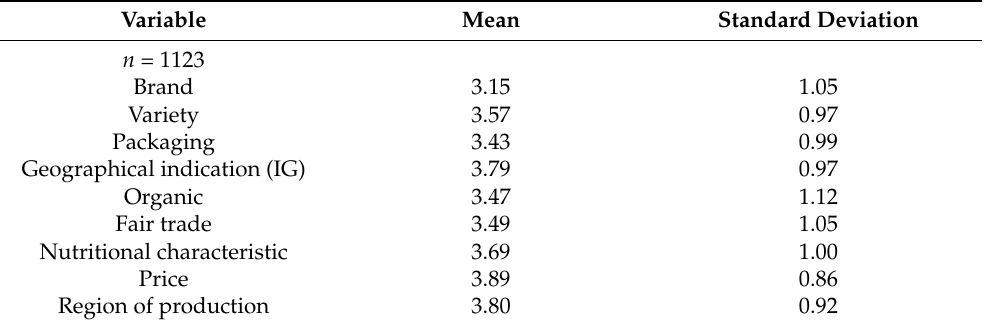
Table 2. Date fruits attributes importance (scale: 1—Not important; 2—Somewhat important; 3—Slightly important; 4—Important; and 5—Very